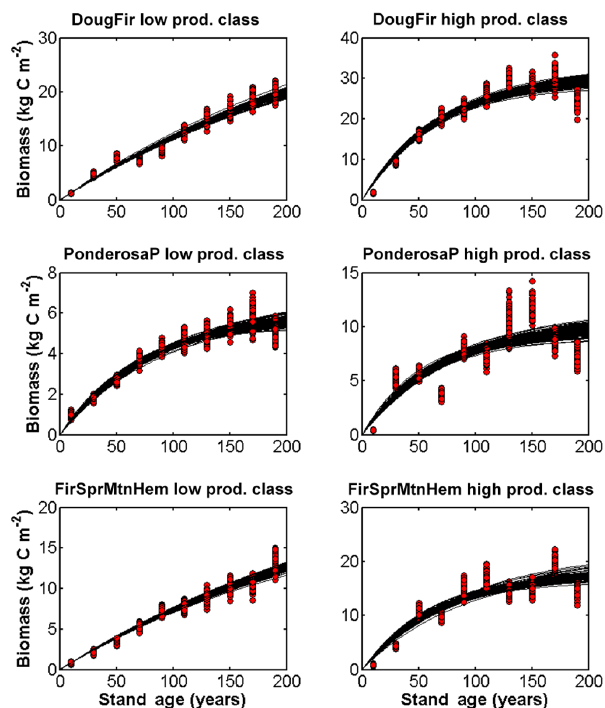
Figure 6. Biomass-age curves sampled from FIA data for each forest-type group and site-productivity class in the PNW region. Curves for the three most abundant forest-type groups are shown (DougFir is Douglas-fir, Ponderosa P is ponderosa pine, and Fir- SprMtnHem is fir/spruce/mountain hemlock). Red dots are inde- pendent samples drawn probabilistically from the FIA